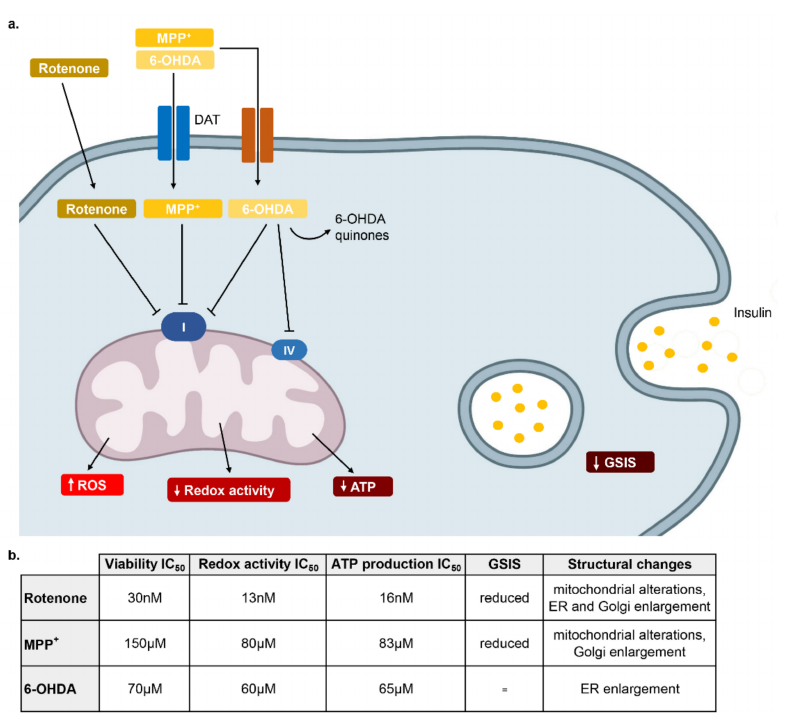
Figure 6. Schematic representation of the mechanisms responsible of rotenone, MPP + and 6-OHDA toxicity in β -cells. ( a ) Rotenone, highly lipophilic, enters the cell freely, it reduces GSIS and it strongly inhibits mitochondrial Complex I, causing an increase of ROS production that is responsible of cell distress. MPP + enters the cell through DAT and other transporters and then it has a mechanism similar to rotenone. 6-OHDA enters the cell through DAT transporter and then it transforms to 6-OHDA quinones responsible of the formation of H 2 O 2 and other oxidative species. It also reduces mitochondrial complex I and IV activity but it does not affect GSIS. ( b ) Table summarizing the IC 50 of the three neurotoxins in the different assays and morphological changes analyzed with electronic